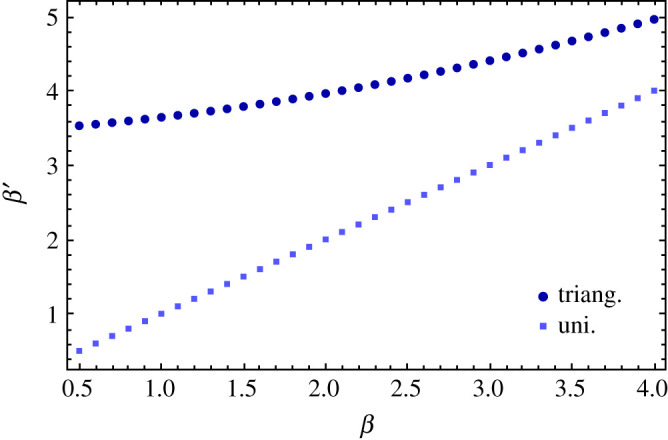
Numerical estimation of β′ as a function of β according to equation (3.4), given π′(s), π^′(ξ) uniform and (i) π(s)=1,π^(ξ)=1 (uniform pdf with s, ξ ∈ [0, 1]) and (ii) π(s) = 2s, π^(ξ)=2ξ (triangular pdf with s, ξ ∈ [0, 1]).